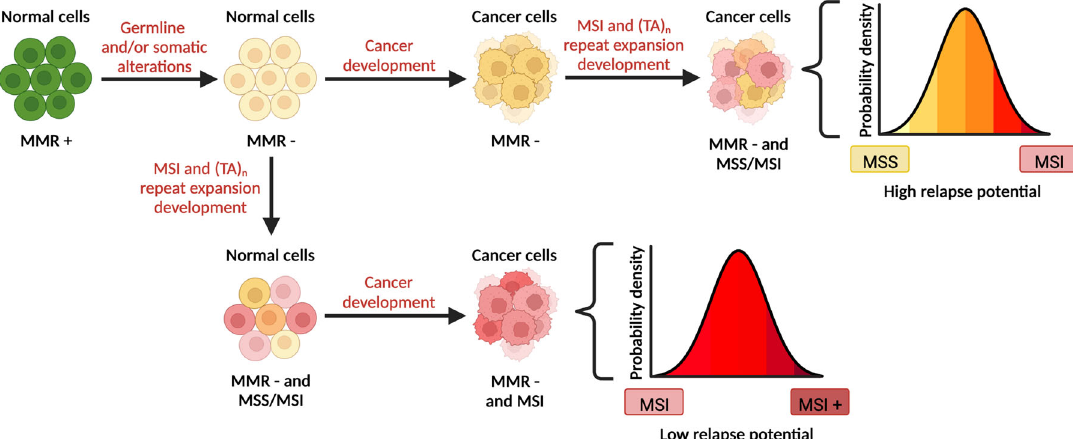
Fig. 1 Temporal differences in MSI and cancer development might lead to contrasting clinical outcomes upon WRN inhibition. Schematic outlining the possible paths towards developing MSI tumours with (TA) n repeat expansions that can be targeted with WRN inhibitors. Acquiring MMR de fi ciency, through germline and/or somatic alterations in MMR genes, is a necessary fi rst step towards MSI and tumour development. MMR de fi cient cells can become cancerous before developing MSI and (TA) n repeat expansions (top branch) or develop MSI and (TA) n repeat expansions before becoming cancerous (bottom branch) potentially leading to different clinical outcomes. The therapeutic window of WRN inhibitors ultimately depends on MSI status and the degree of (TA) n repeat expansions. Microsatellite stable (MSS) and MSI cells with (TA) n repeat expansions are highlighted in yellow and red respectively. Figure was created with